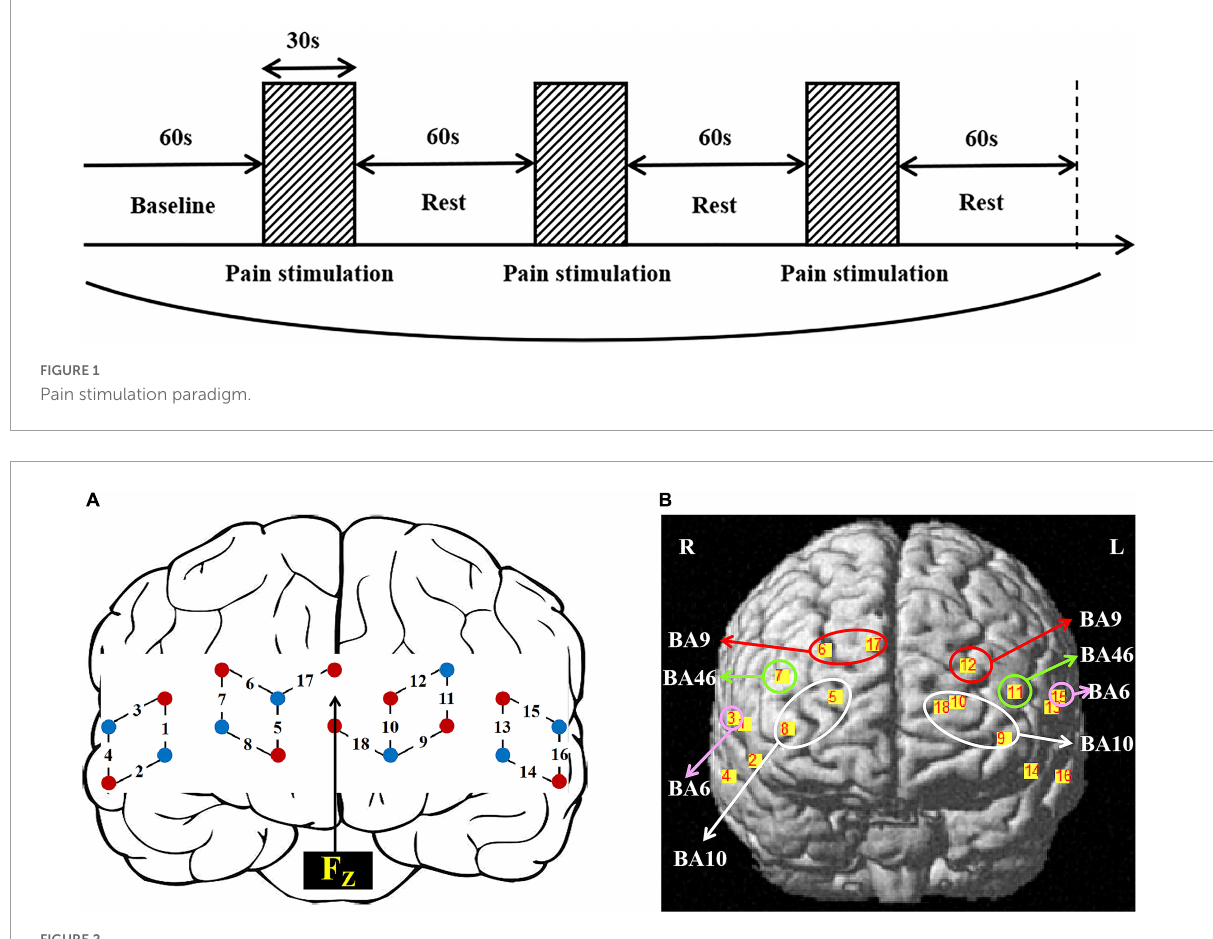
FIGURE2 Setup of fNIRS probes and channels. (A) Schematic illustration of the fNIRS probe layout. (B) The topographical distribution of the fNIRS recording